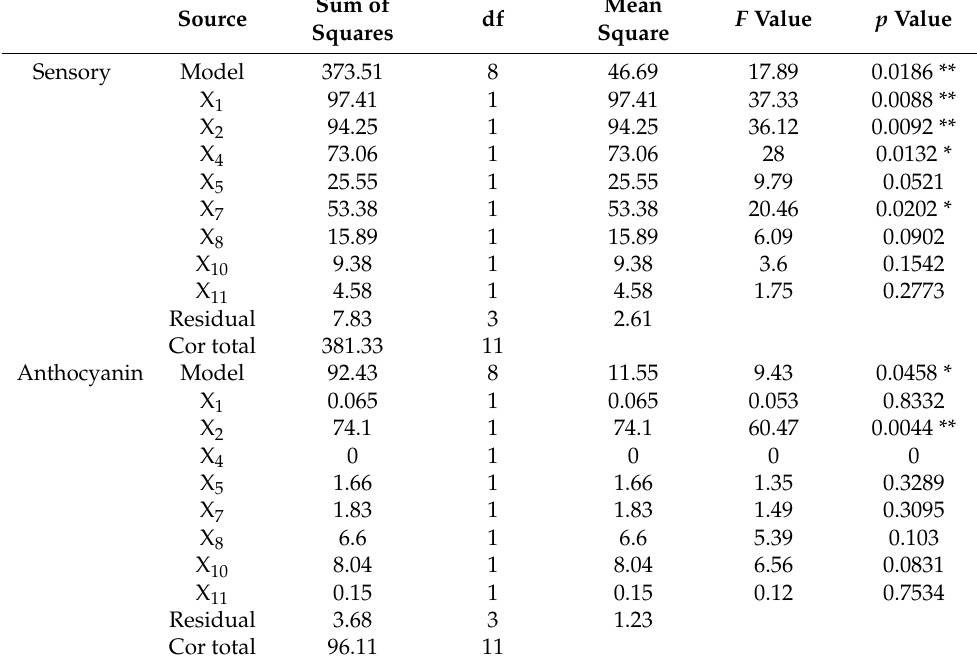
Table 4. ANOVA of the Plackett–Burman